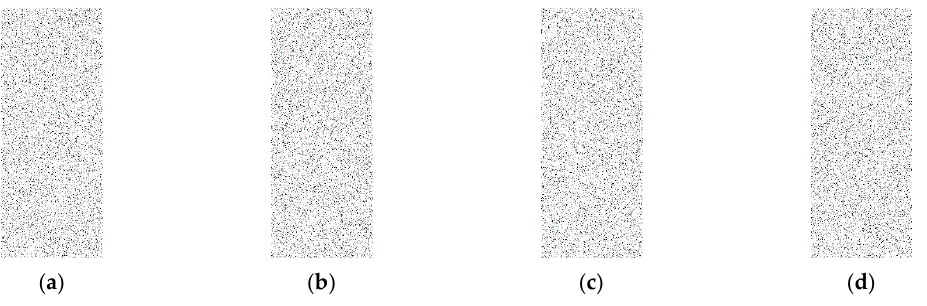
Figure 8. Rate is 0.05, ( a ) is the completely random scenarios; ( b ) is DUD scenarios; ( c ) is DAD scenarios and ( d ) is CAD cases, and all images look very similar to each other.